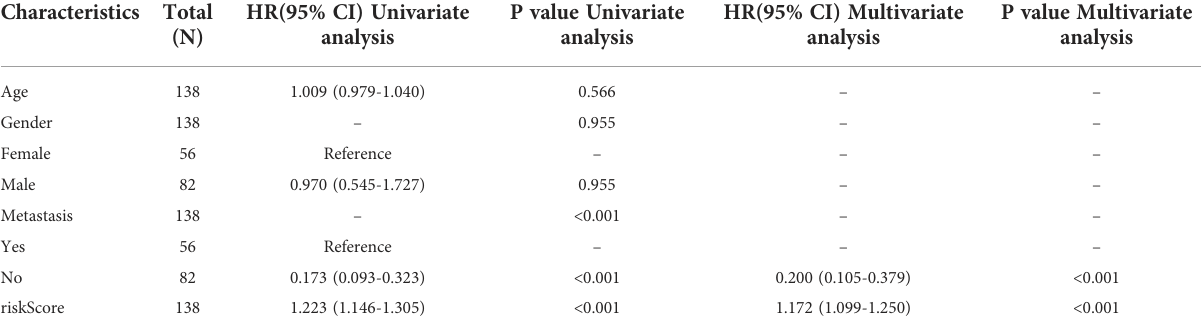
TABLE 1 Univariate and multivariate COX regression analyses for age, gender, risk score, and metastasis status in OS tissues. Characteristics Total